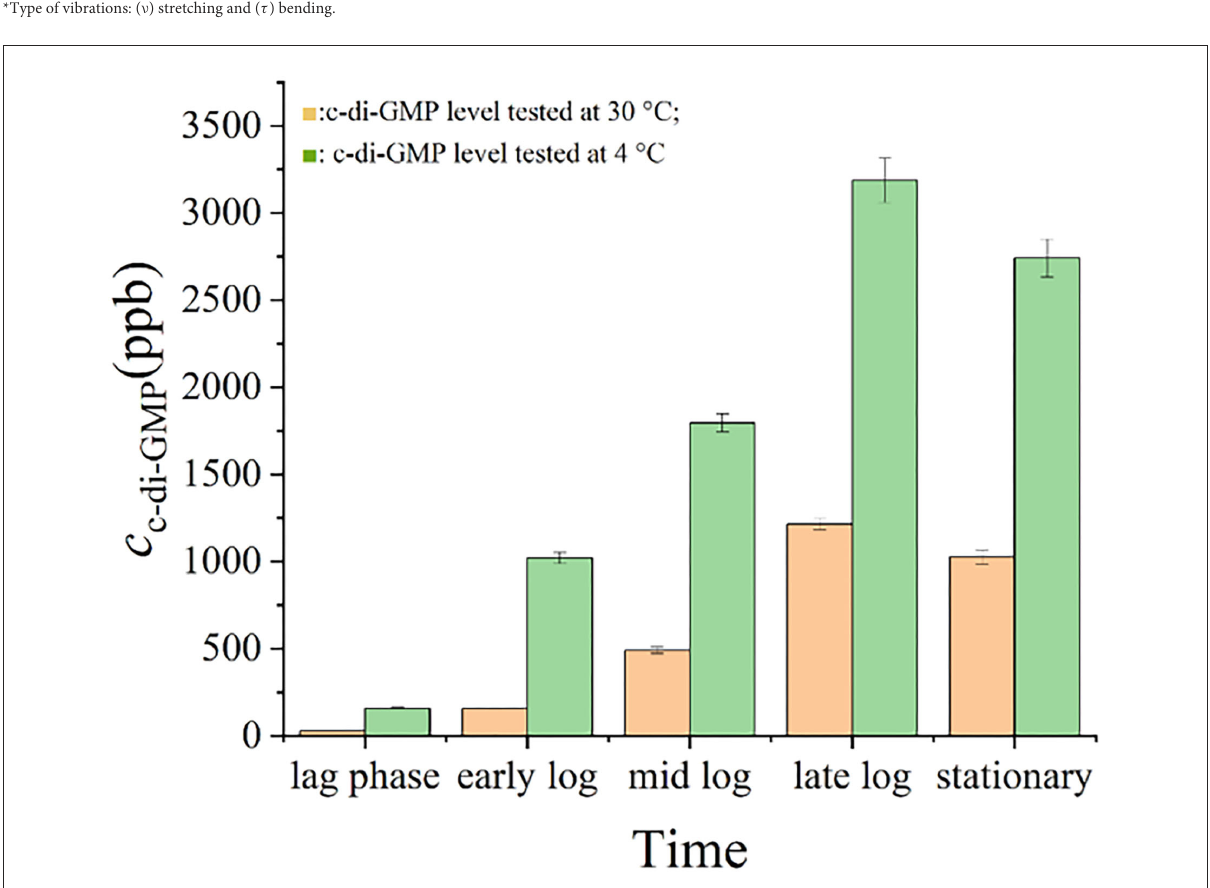
FIGURE5 c-di-GMP levels in S. putrefaciens WS13. c-di-GMP levels in S. putrefaciens WS13 under 30 ( ) and 4 ◦ C (